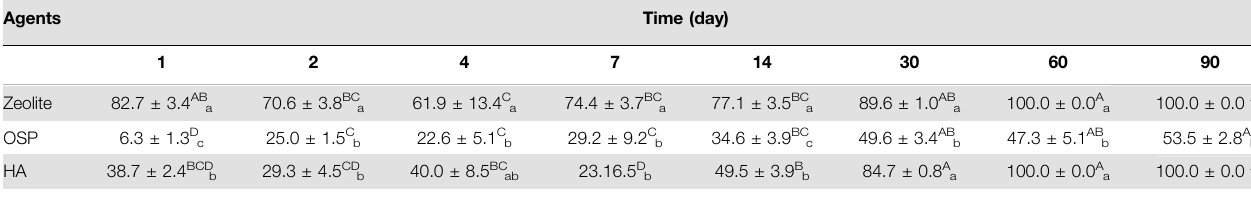
TABLE 6 | The removal ef fi ciency (%) of 1000 μ g/L of LMG in freshwater treated with three agents (200 mg/L) at observation point during 90 days. Agents Time (day)